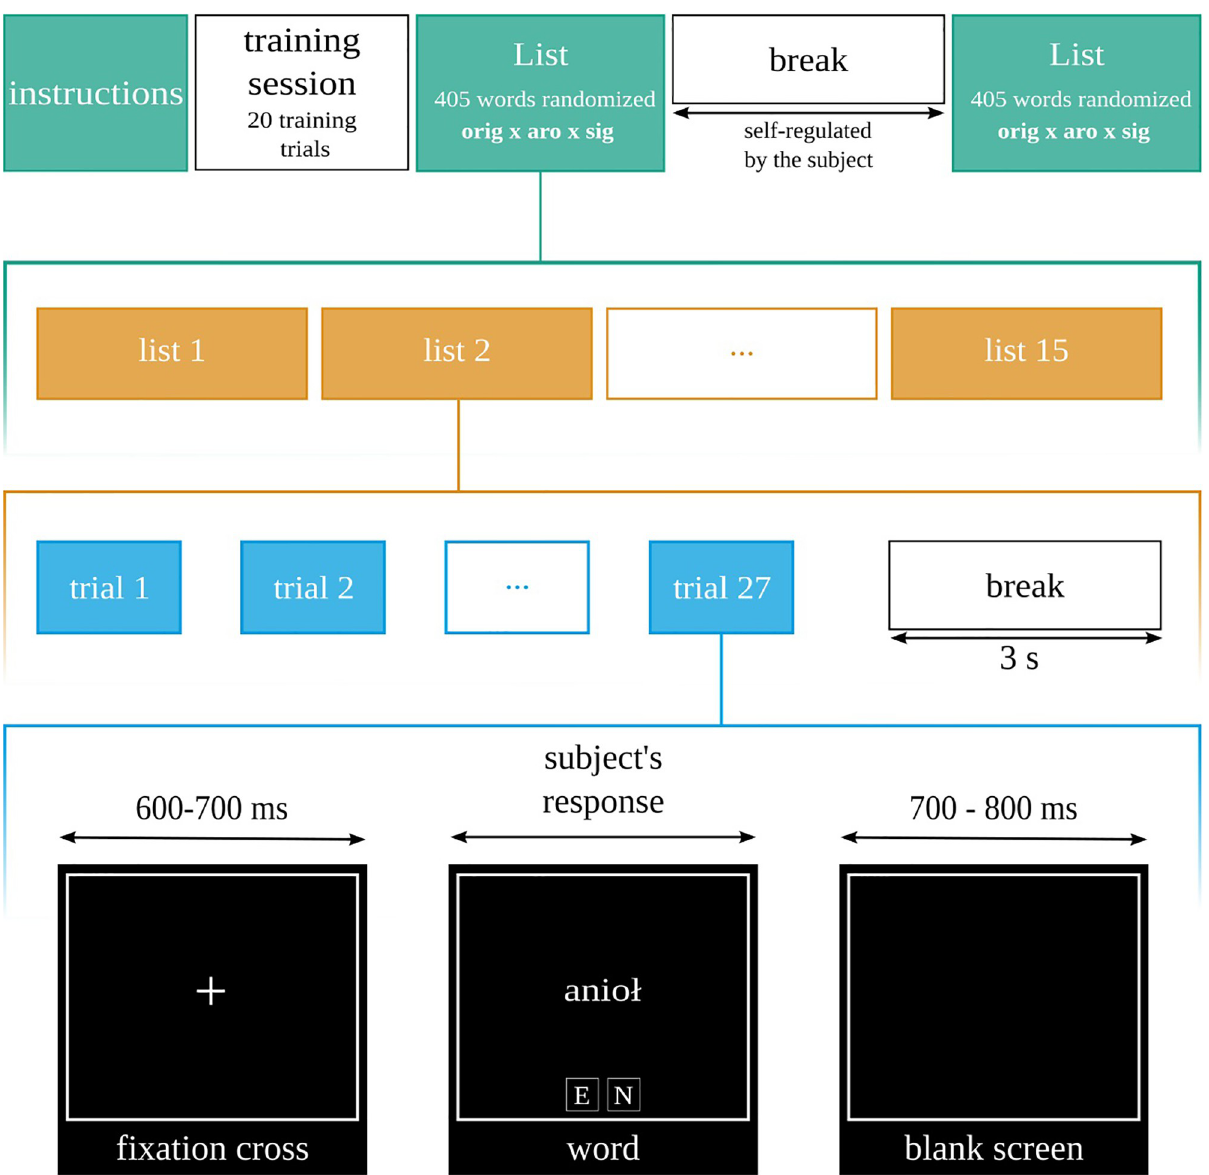
Fig 1. Diagram of the experimental protocol. The task was to assess if the word was emotional or neutral. interval for fixation cross). After every 27 trials, participants could rest and blink for three sec- onds. The whole procedure is presented in Fig 1. 2.5.1 Apparatus. The stimuli were displayed on a standard PC monitor. The stimuli were synchronised to EEG data using a custom-built circuit that recorded the brightness of a small square on display, hidden from the subject’s sight. Its illumination varied synchronously with the content of the display. We registered EEG signal from 19 electrode sites: Fz, Cz, Pz, Fp1/2,